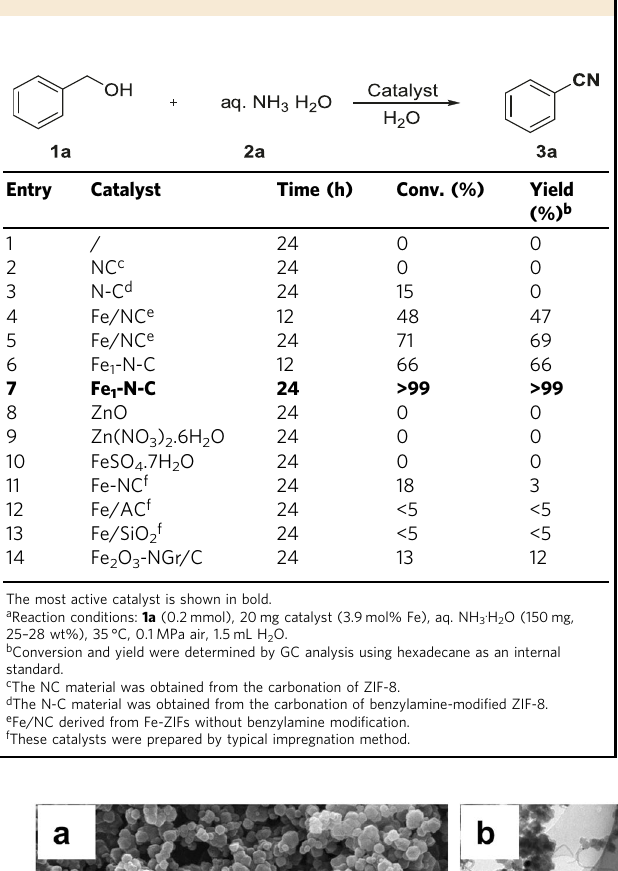
Table 1 Catalyst evaluation for the ammoxidation of benzyl alcohol a